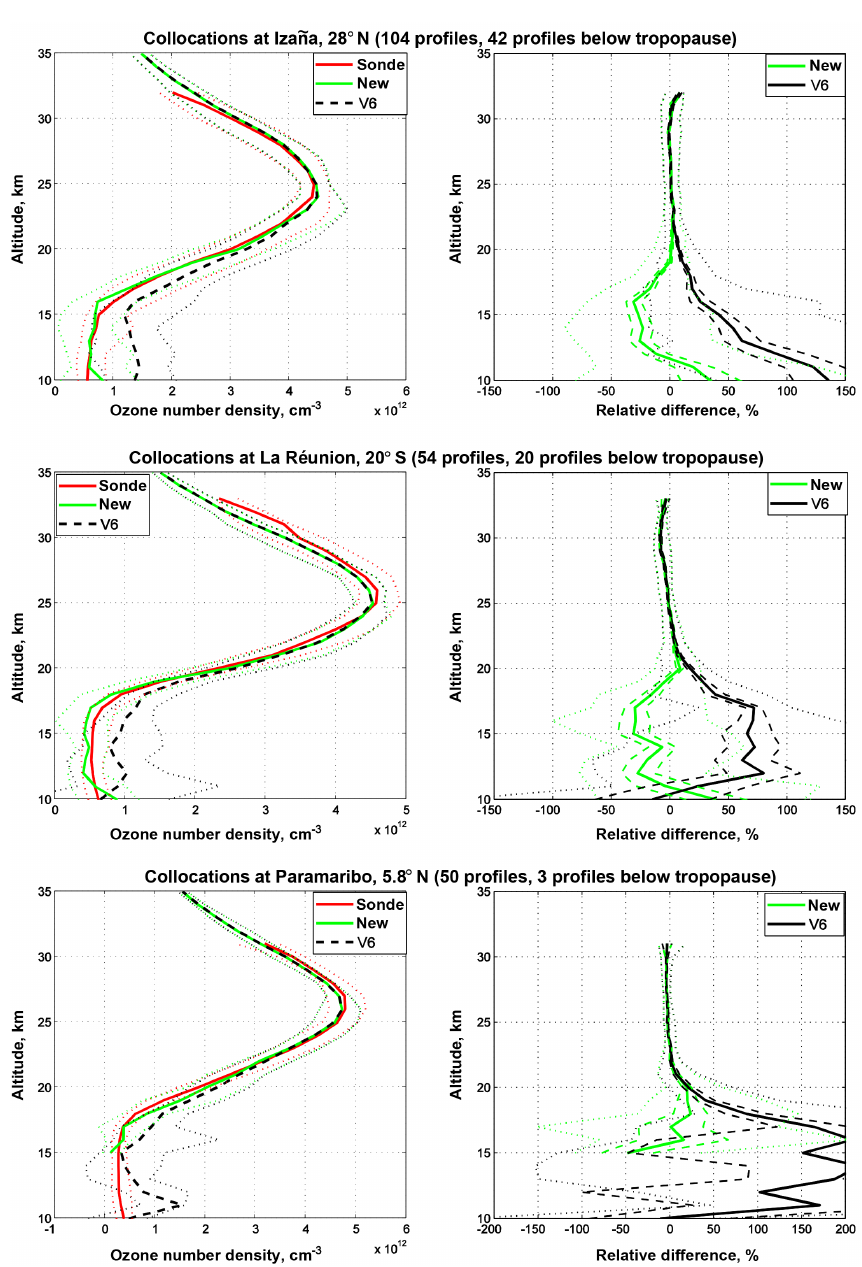
Figure 9. Statistics of comparison with ozonesondes at Izaña (top), Réunion (center) and Paramaribo (bottom). Left: median profiles (solid lines) and 16th and 84th percentiles (dotted lines) indicating the spread of relative differences. Right: solid lines indicate median of relative differences, dotted lines the 16th and 84th percentiles, and dashed lines indicate the standard error of the